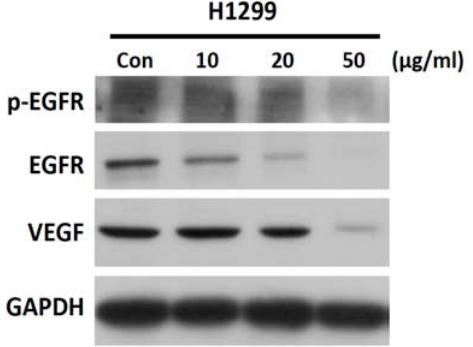
Figure 6. SH ‐ EAE reduces the EGFR and VEGF signaling in NSCLC cells. Expression of phospho ‐ EGFR (Tyr845), EGFR, and VEGF were analyzed by western blot in NSCLC cell line H1299. GAPDH was used as the loading control. Data are representative of three independent experiments.